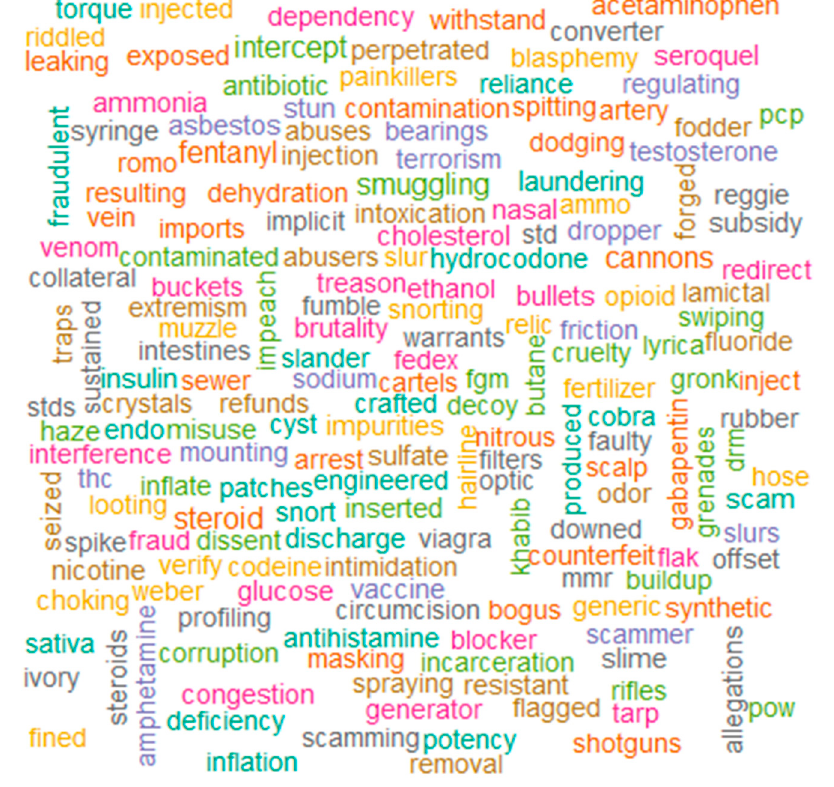
Figure 2. A word cloud generated from the most aligned words to the decision direction separating author vectors from /r/Opiates and /r/CasualConversation. This was generated using the restricted Stanford Twitter GloVe embedding with a 20 thousand size vocabulary.